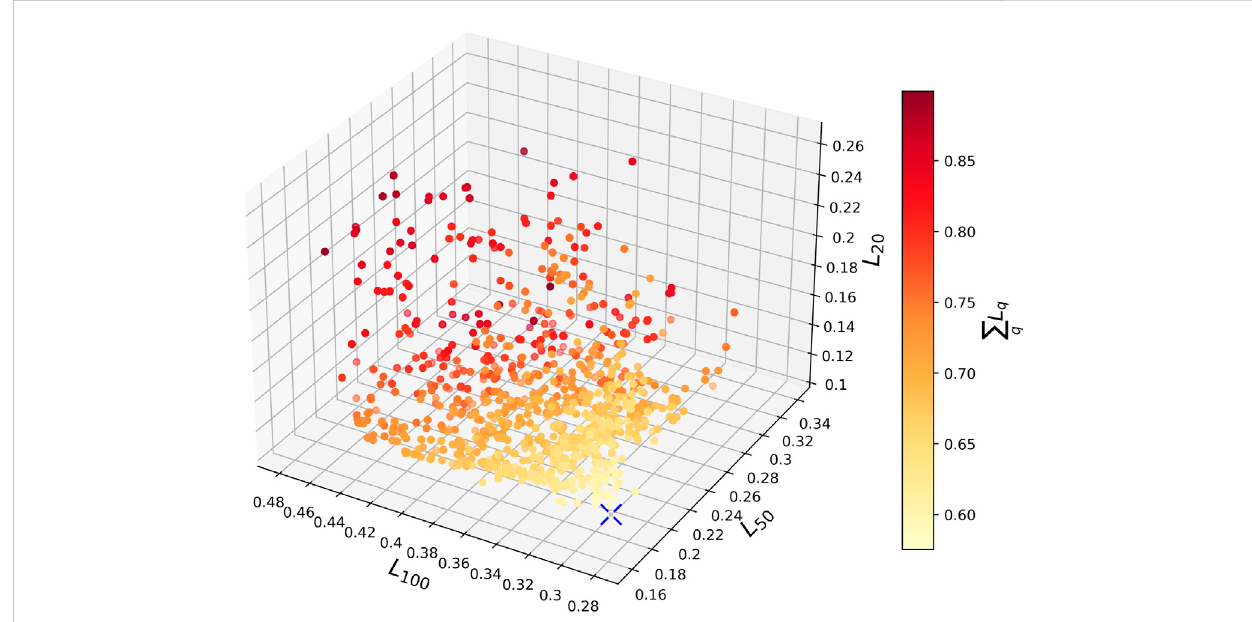
FIGURE 3 Lossfunction L q distributionofthreebeamchargesofthelast40generationsintheoptimizationofmultiplexedcon fi gurationwithcustomizedlaser spot size. The color map means the sum of three loss functions. The blue cross represents the optimal point with minimum sum of loss